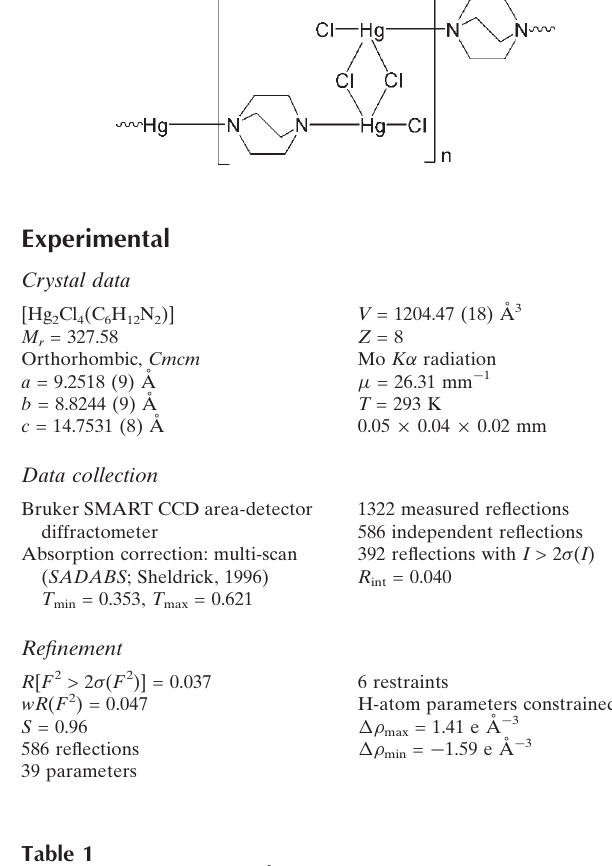
Hydrogen-bond geometry (A˚ , (cid:5)